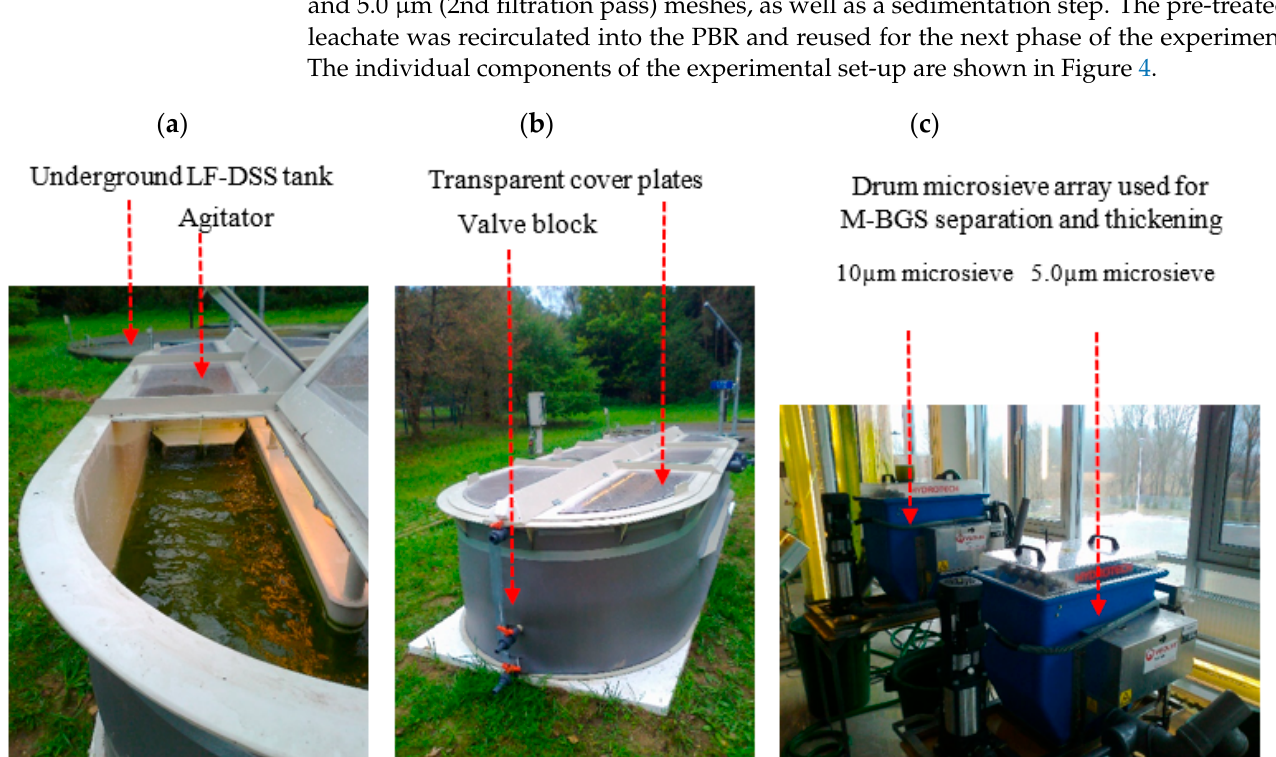
Figure 4. Experimental set-up for LF-DSS treatment ( a , b ) coupled with M-BGS production and a two-stage biomass separation system ( c ).